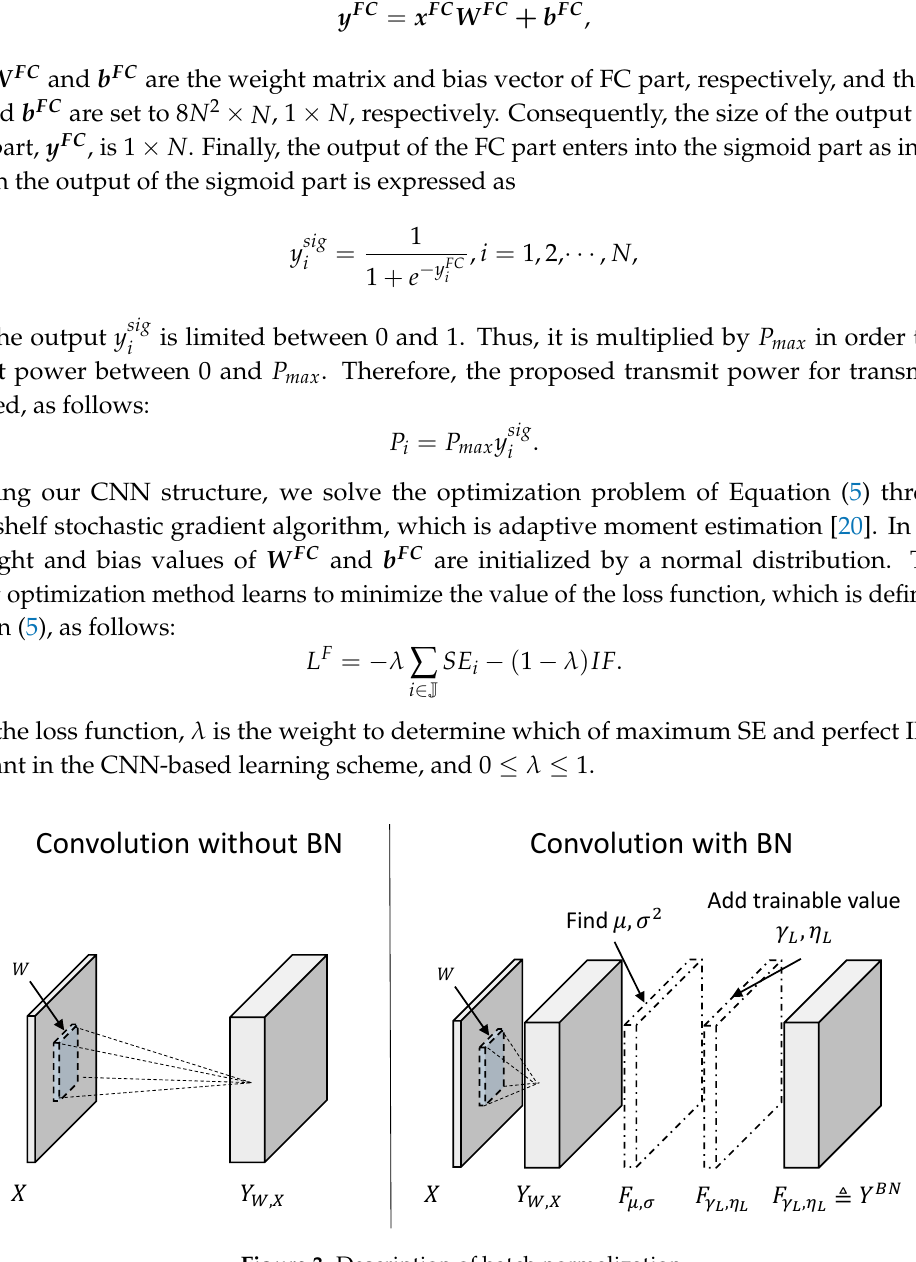
Figure 3. Description of batch